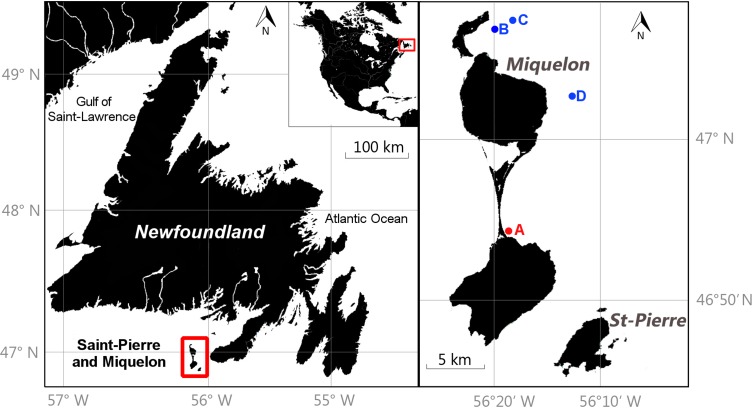
Map of Saint-Pierre and Miquelon and neighboring countries.(A) Location of the S. solidissima sampling site. (B and C) The two temperature and pressure monitoring sites. (D) The vertical salinity profile site.